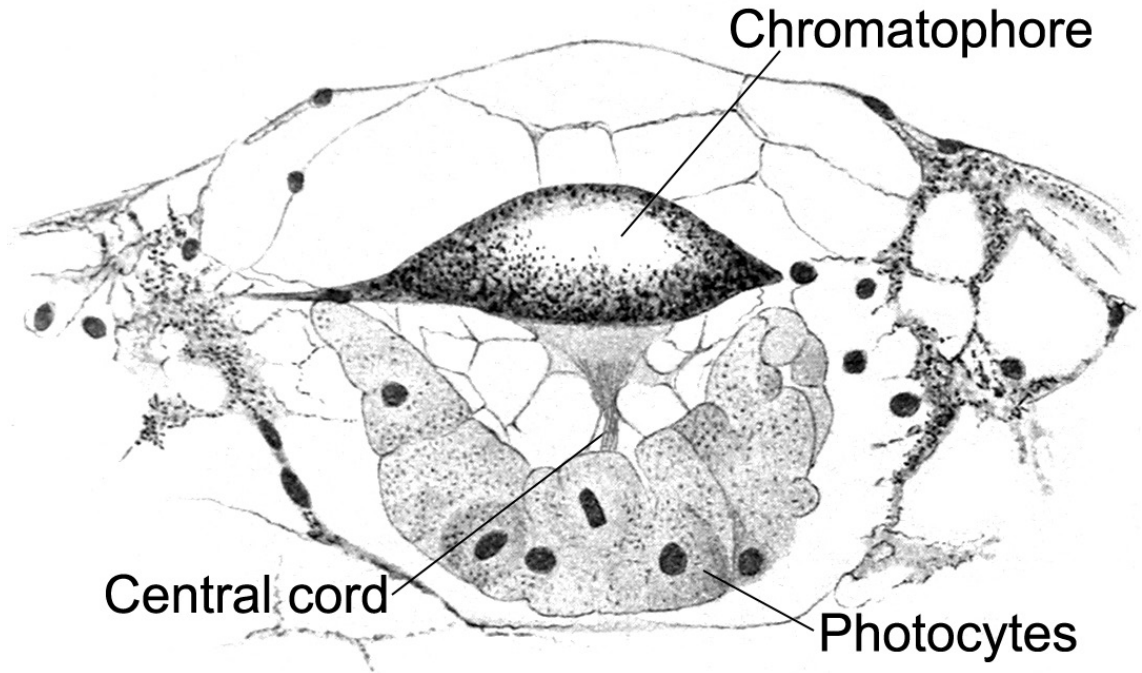
Fig. 1. Longitudinal section through an integumental photophore of Mastigoteuthis agassizii Verrill, 1881 (modified from Chun